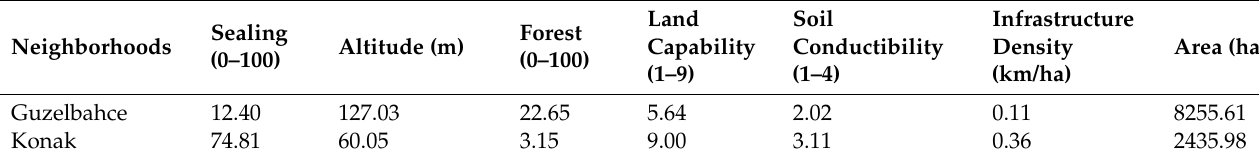
Table 7. Comparison between Guzelbahce and